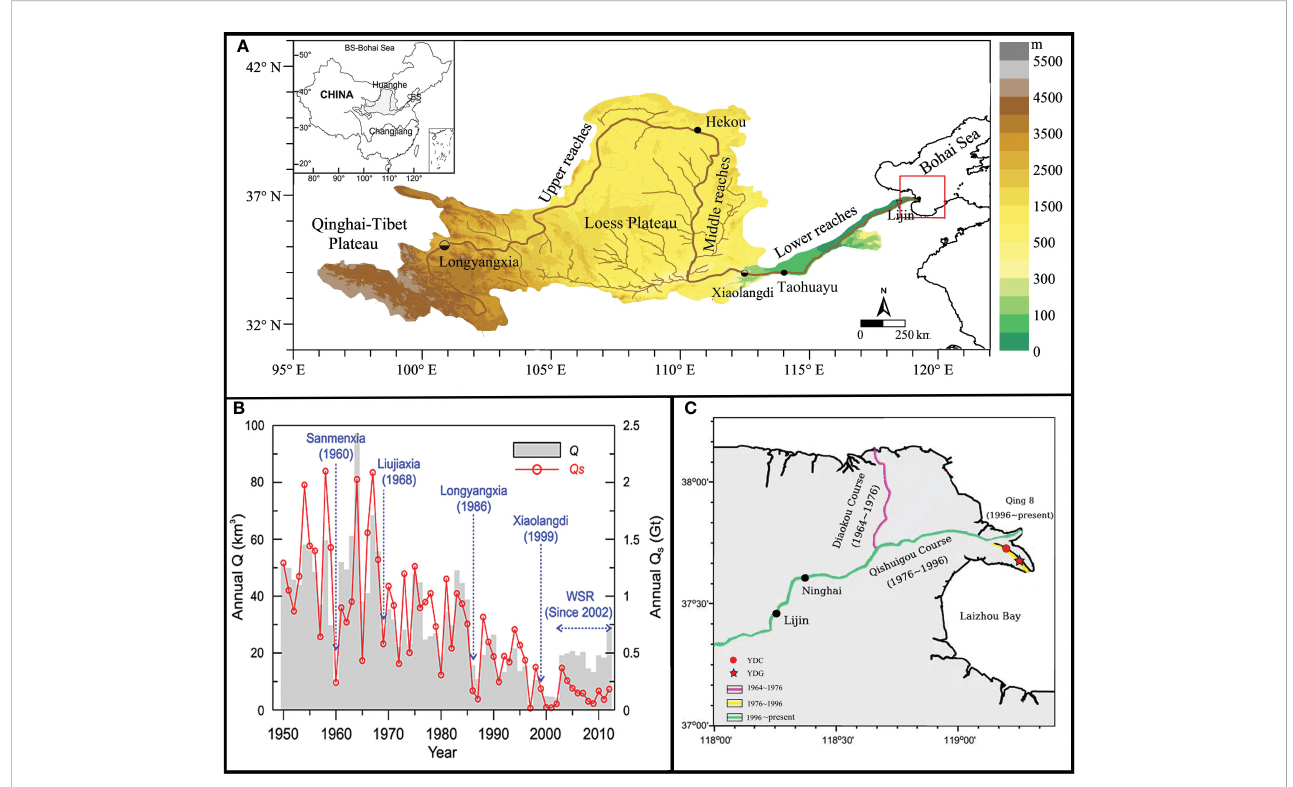
FIGURE 1 (A) Map of the Yellow River basin (Liu et al., 2022). (B) Annual water and sediment discharges from the Yellow River to the sea recorded at Lijin Station, 1950 – 2012. WSR is the Water – Sediment Regulation Scheme since 2002 (Hu et al., 2015). (C) Map of river channel changes and core locations in the Yellow River delta (Wu et al.,